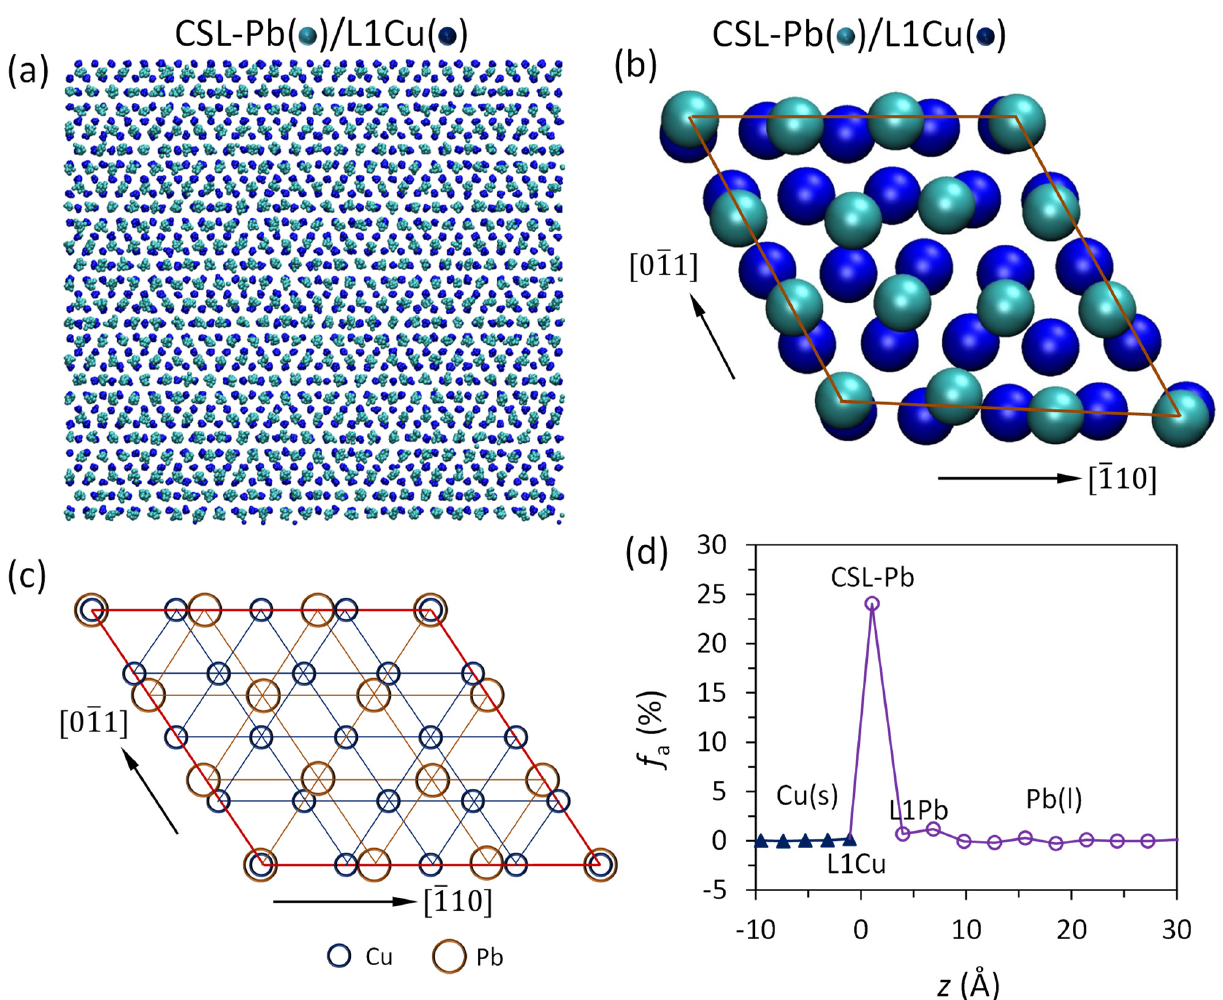
Figure 10. Formation of coincidence site lattice (CSL) during prenucleation in the Pb(l)/Cu(s) system [27]. ( a ) Time-averaged atomic positions (top view) of the CSL layer (CSL-Pb) superimposed on that of L1Cu in the Pb(l)/Cu(s) system equilibrated at 625 K. ( b ) Snapshot of CSL-Pb/L1Cu showing atomic arrangement in the CSL unit cell; ( c ) the schematic illustration of CSL unit cell shows the matching rule, 3 d Pb<110> = 4 d Cu<110> , where d is the atomic spacing along the <011> direction; and ( d ) the accommodated misfit, f a , as a function of distance from the interface. The CSL accommodates a major part (25%) of the lattice misfit in the Pb(l)/Cu(s) systems, and only a small residual lattice misfit of 2.3% needs to be accommodated during the subsequent heterogeneous nucleation.